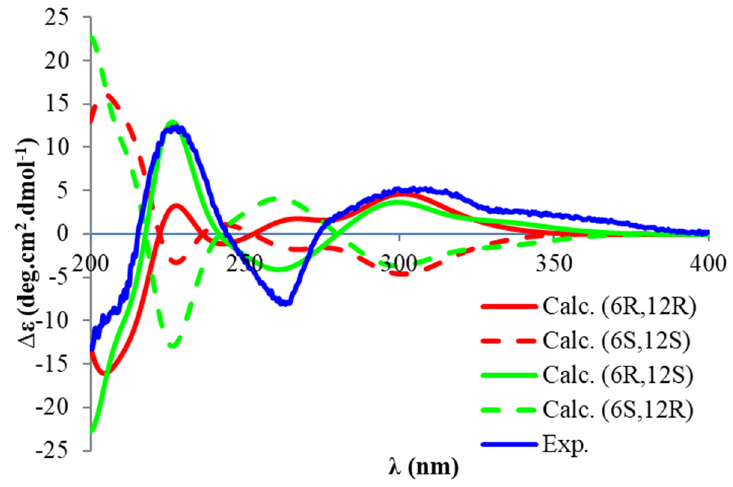
Figure 3. Experimental electronic circular dichroism (ECD) spectrum of 2 and calculated ECD spectra of (6 R ,12 R ) − 2 , (6 S ,12 S ) − 2 , (6 R ,12 S )- 2 and (6 S ,12 R ) − 2 .